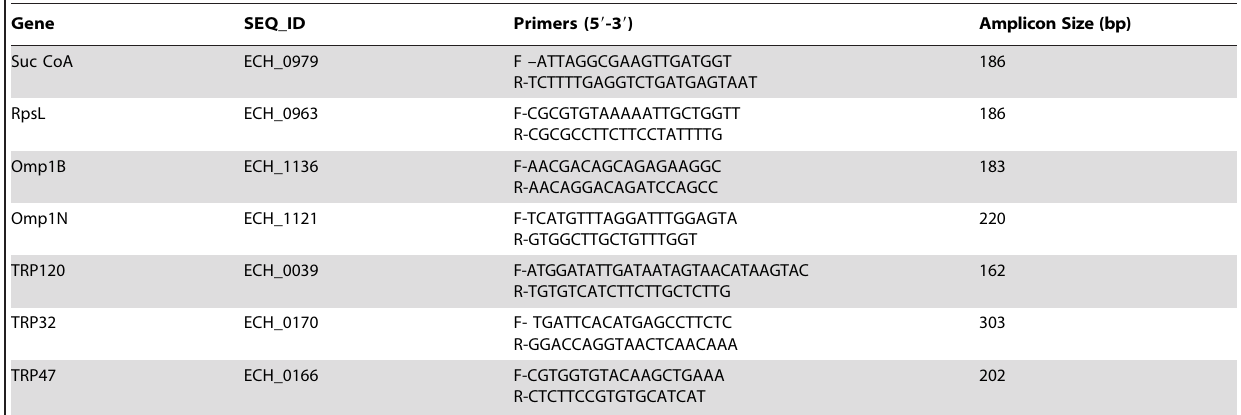
Table 4. Primers for